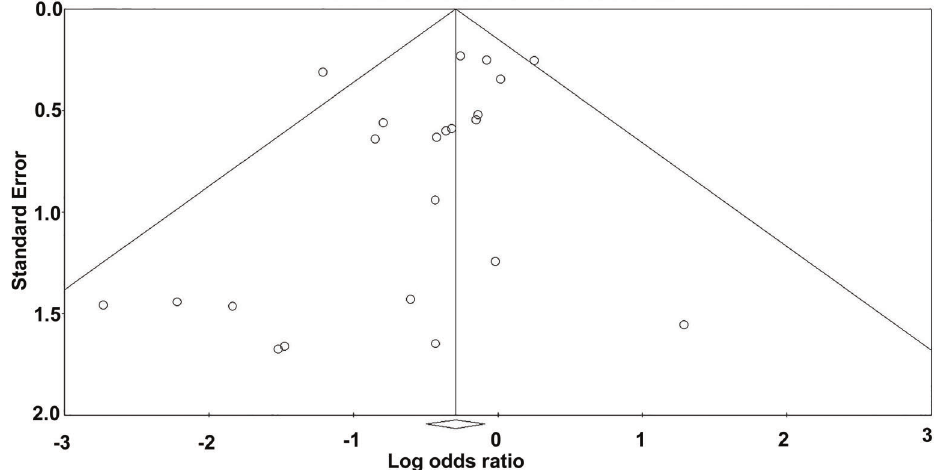
Figure 5. Funnel plot for publication